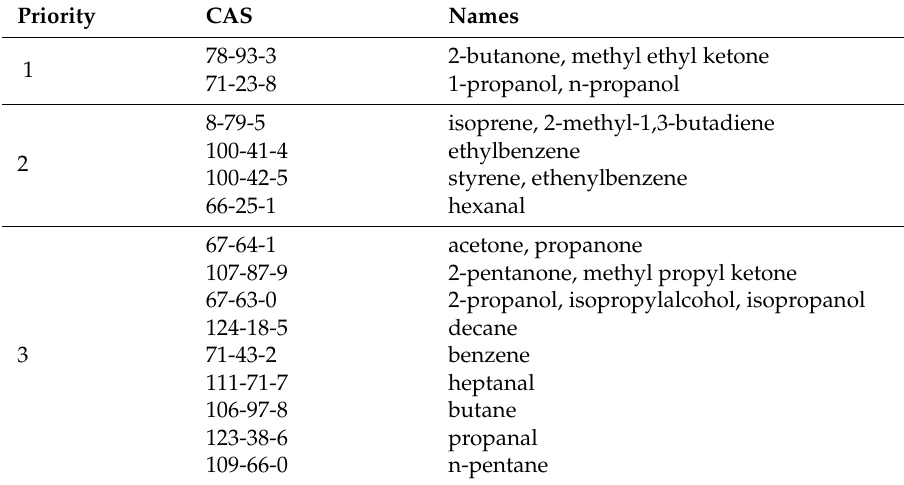
Table 1. Most relevant biomarkers